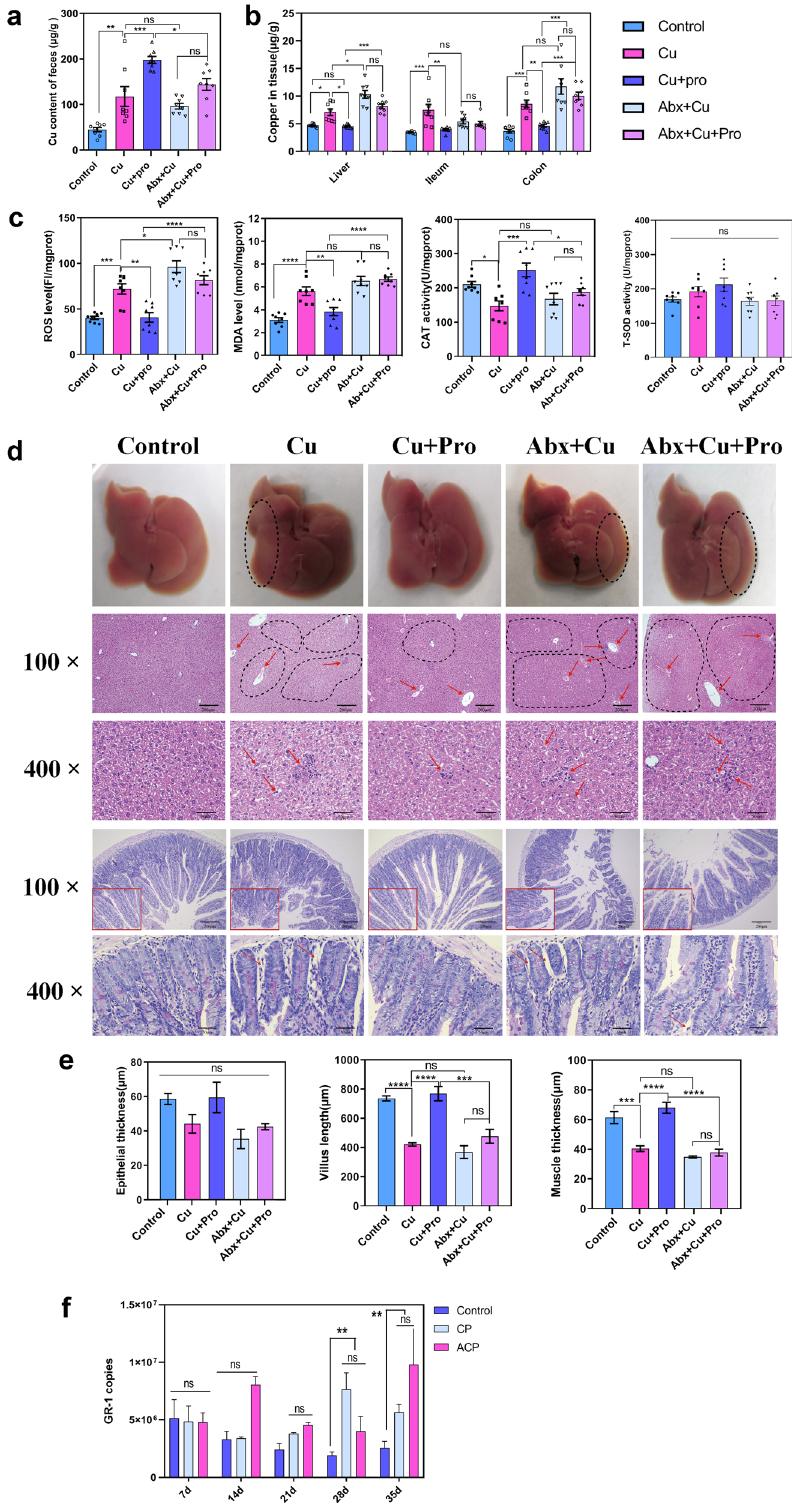
and pyknotic nuclei) and small intestine (shorter villus length, (1) Oral gavage of CuSO 4 solution resulted in signi fi cantly more p < 0.0001; thinner muscle, p = 0.0003) exhibited evident damages Cu excretion in the feces and more accumulation in the tissues after Cu exposure (Fig. 7c – e). (2) Cu-induced damages were than the control (Fig. 7a, b; p feces = 0.0017, p liver = 0.0259, p = 0.0003, and p = 0.0003). OS in the liver was increased, exacerbated in the Abx + Cu group, which resulted in the ileum colon disruption of GM. We detected 18.13% less fecal Cu and the liver (cytoplasmic vacuolization, chromatin condensation,